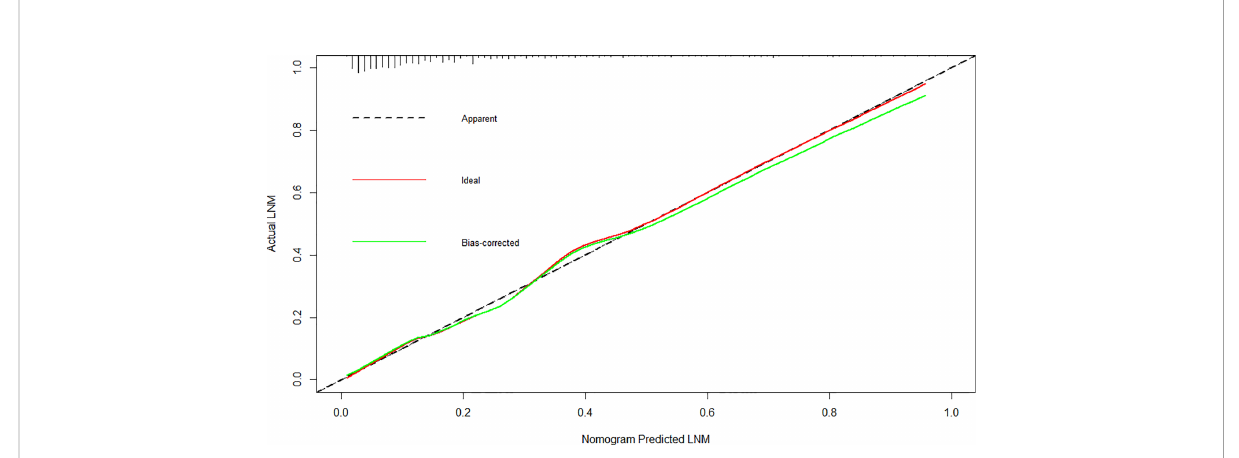
FIGURE 4 Calibration plot for the nomogram for the prediction of lymph node metastasis after endoscopic submucosal dissection in early gastric